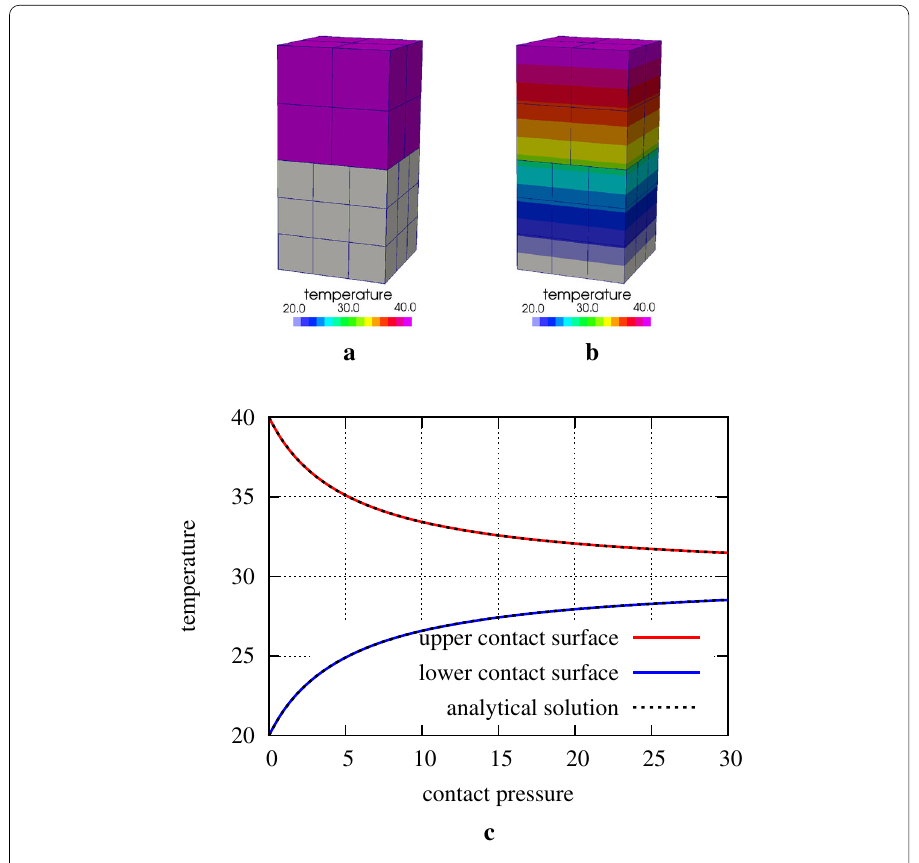
Fig. 3 Stationary heat conduction—temperature distribution at different contact pressures. a p n = 0. b p n = 30. c Interface temperatures over p